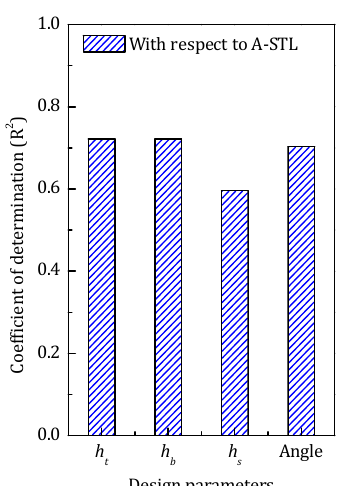
Figure 24. Optimization samples distribution of three design parameters (middle-frequency range). ( a ) Optimization sam- ples distribution of h t ; ( b ) Optimization samples distribution of φ ; ( c ) Optimization samples distribution of h s . Figure 25 shows the coefficient of determination of each design parameter with re- spect to STL avg in the middle-frequency optimization.